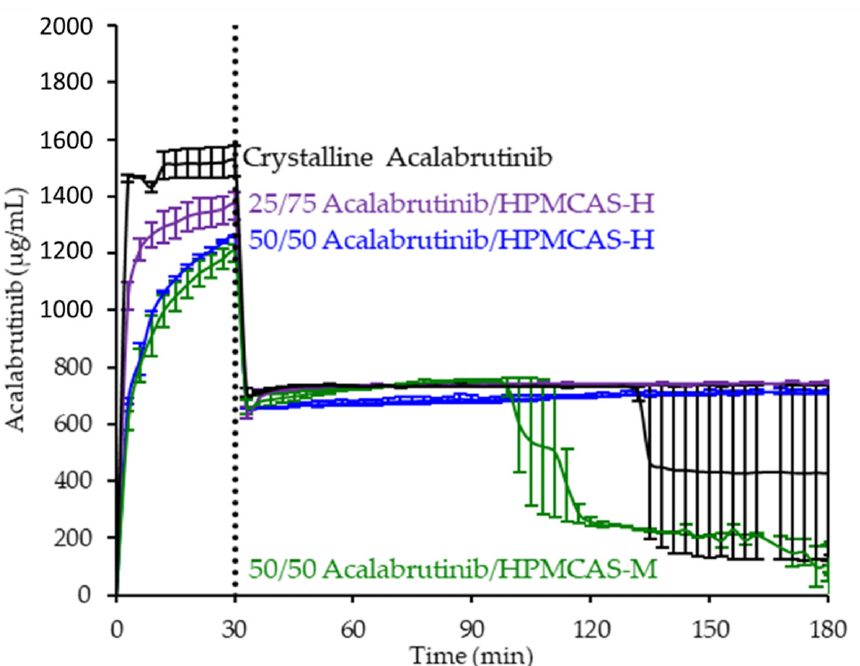
Figure 5. Dissolution profiles of ASD intermediates in a gastric to intestinal transfer dissolution test using a Pion µDiss Profiler under conditions simulating fasted dogs treated with pentagastrin (gastric pH 2) (curves represent average values whereas error bars represent range, n = 2).